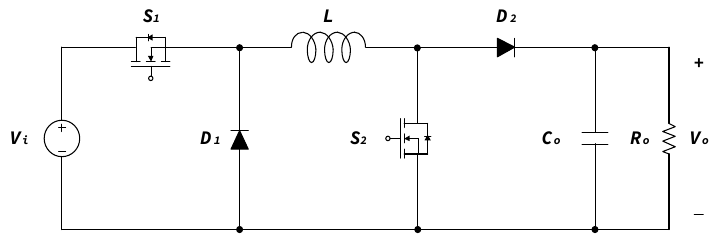
Figure 2. Circuit diagram of the conventional TSBB converter. Table 2. Switch operation of the conventional TSBB converter.